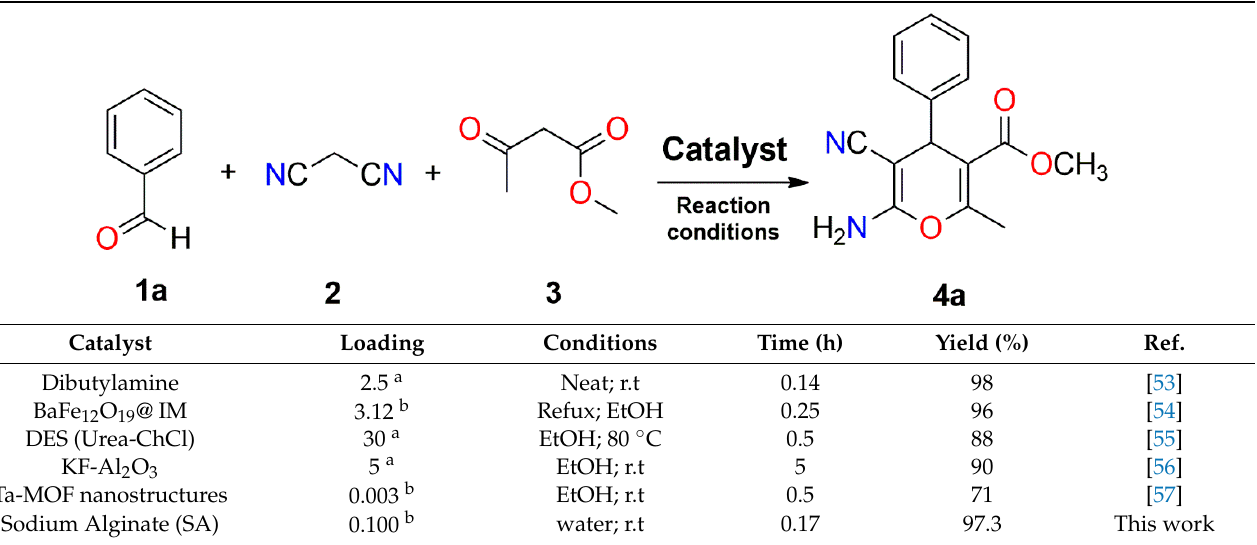
Table 2. Comparative results of catalytic efficiency for the selective synthesis of compound 4a .